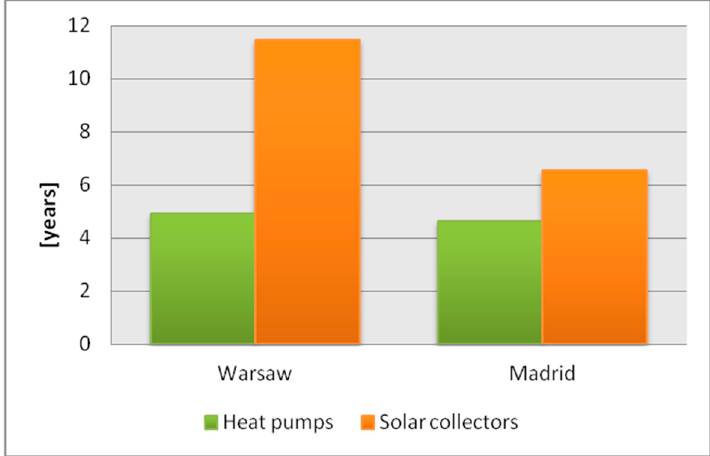
Figure 1. The simple payback time (SPBT) of